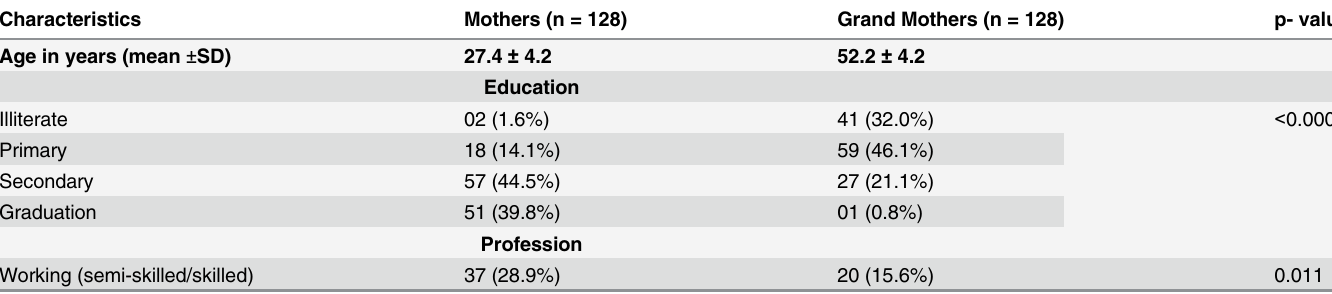
Table 1. Demographic characteristics of the population studied.